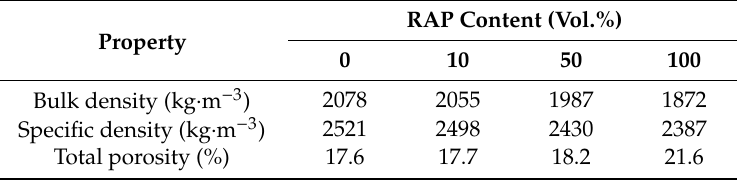
Table 6. Structural properties determined on dried hardened